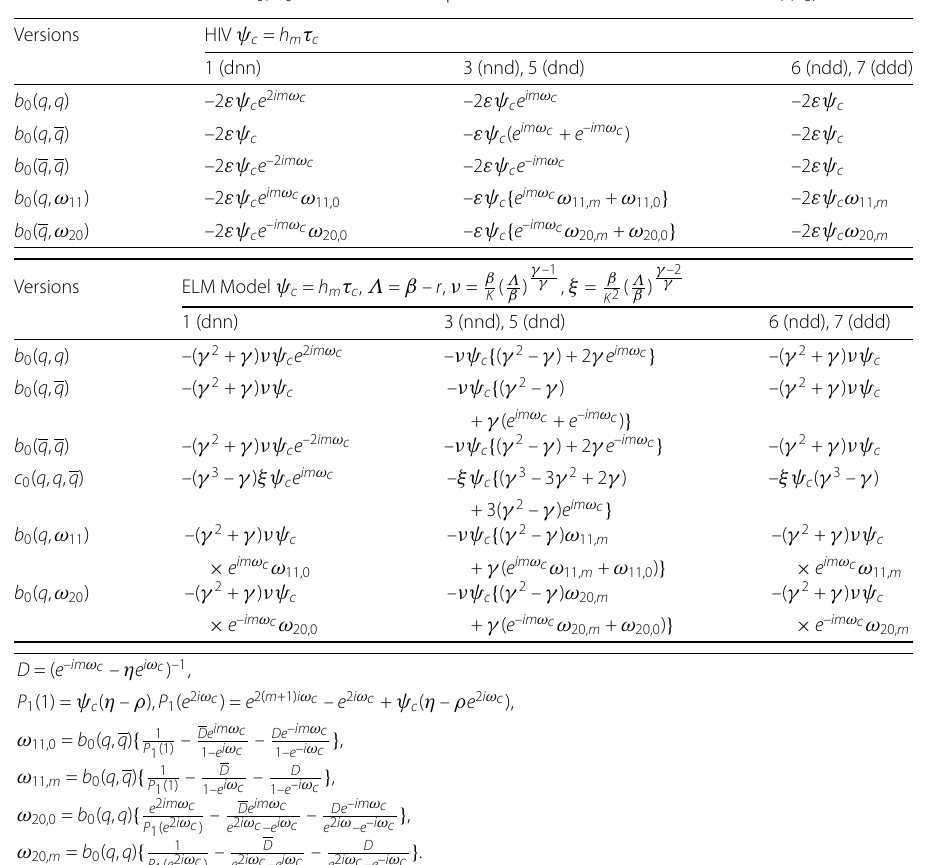
Table 7 Formulas for the b 0 , c 0 terms and inner products in the the critical constant c 1 ( τ c